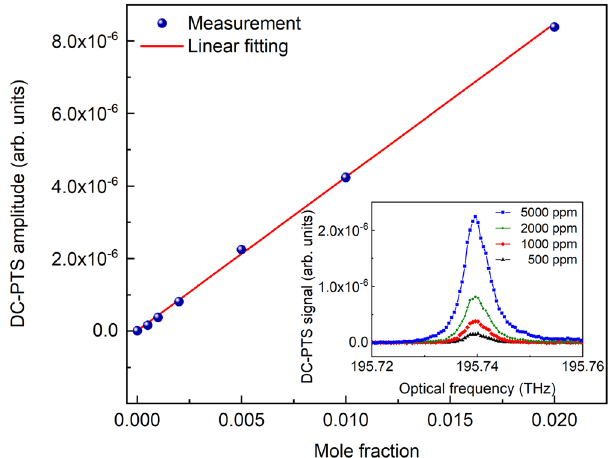
Fig. 4 Variation of the DC-PTS amplitude with gas concentration. The DC-PTS system shows an excellent linear response with an R 2 value of 0.999. Inset: representative DC-PTS spectra of C 2 H 2 with different concentrations.